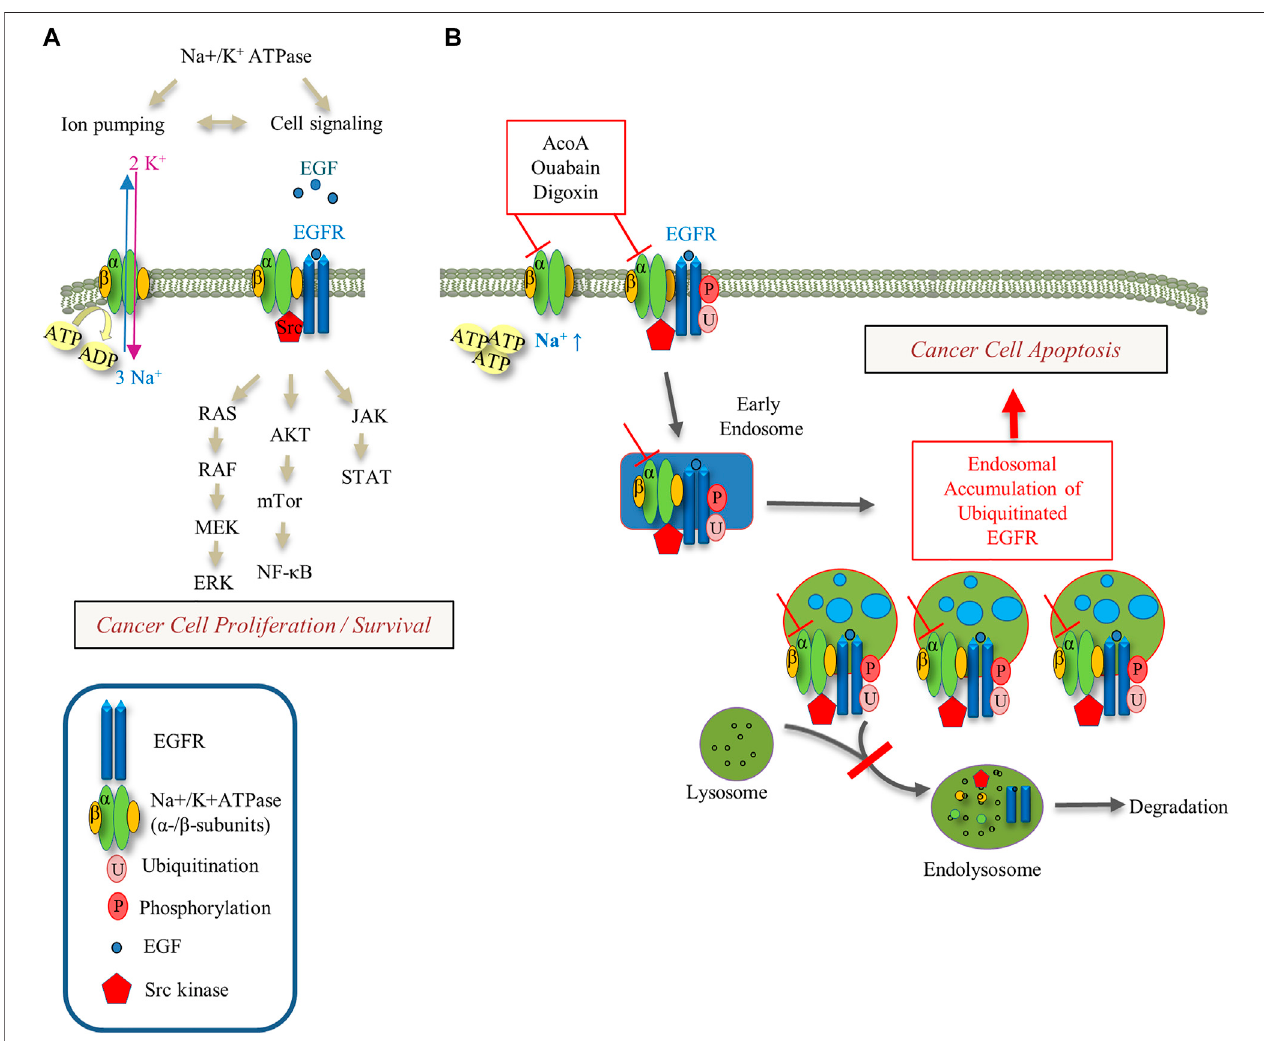
FIGURE9| SchematicofNa + -K + -ATPaseandEGFR signaling pathwaysand theirmodulationbycardenolide glycosides. (A) Theinteraction betweentheNa + /K + - ATPase, EGFR and Src kinase regulates downstream signaling pathways with impact on cancer cell proliferation and survival. (B) Cardenolide glycoside-induced inhibition of the Na + /K + -ATPase ion pumping function increases intracellular Na + and ATP levels. Inhibition of the Na + /K + -ATPase increases intracellular Na + and inhibits EGF-induced EGFR degradation yielding endosomal EGFR arrest. This perturbation of EGFR traf fi cking may trigger apoptotic cell death.